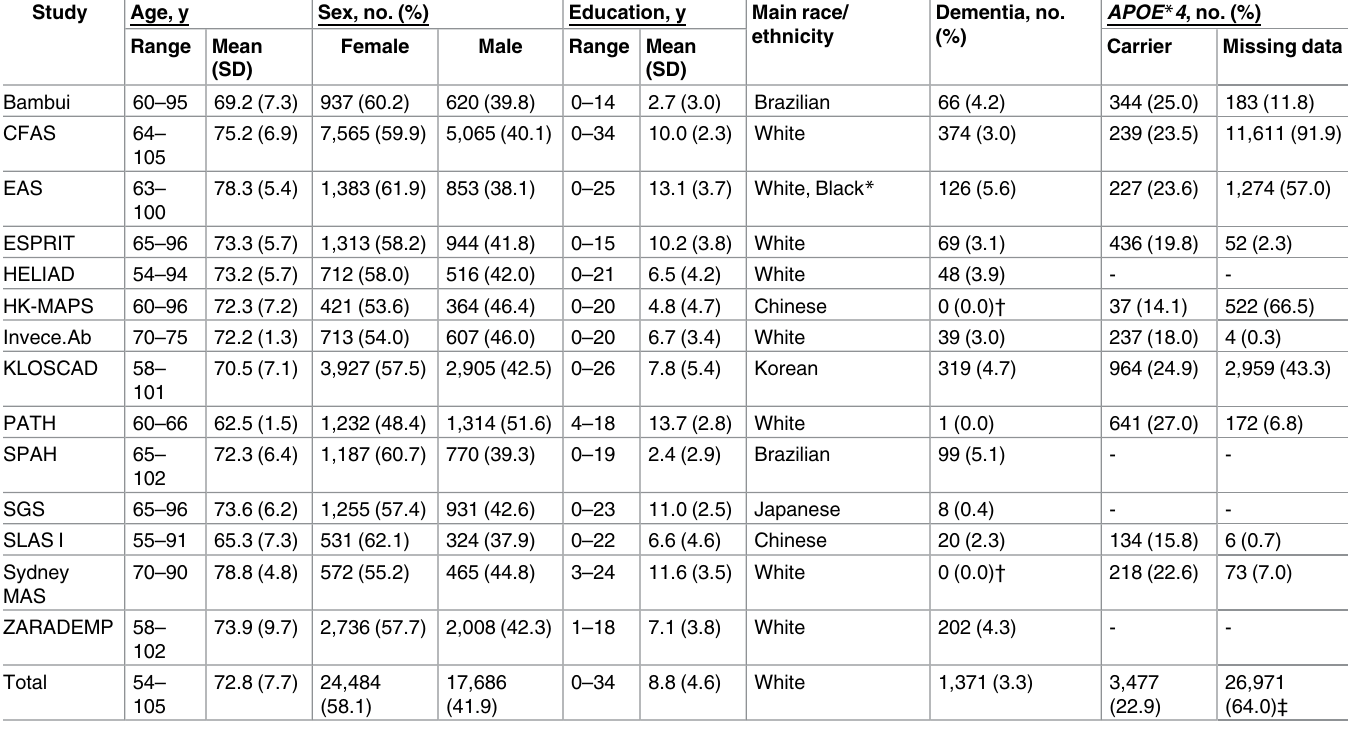
Table 2. Characteristics of the cohorts at